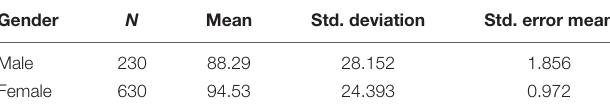
TABLE 2 | Descriptive analysis for gender.